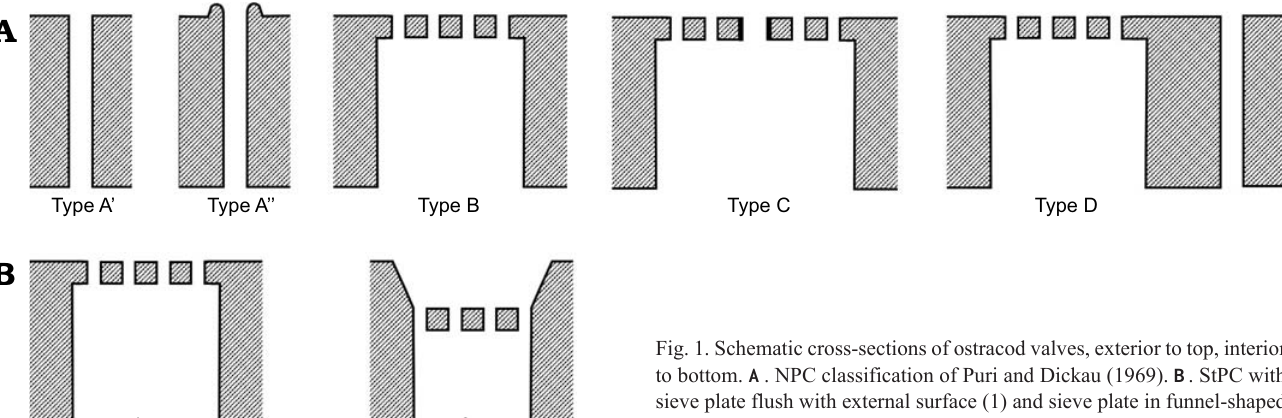
Fig. 1. Schematic cross-sections of ostracod valves, exterior to top, interior to bottom. A . NPC classification of Puri and Dickau (1969). B . StPC with sieve plate flush with external surface (1) and sieve plate in funnel-shaped depression